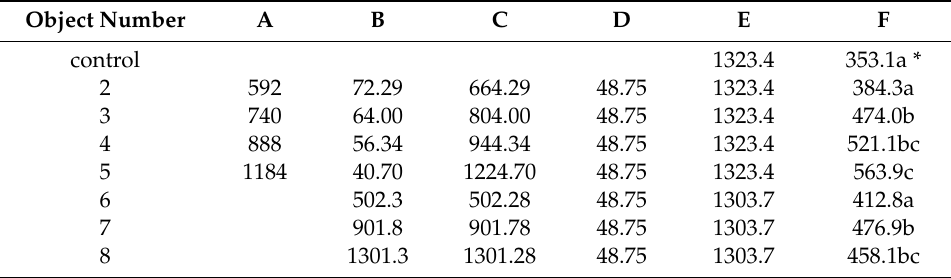
Table 4. CO 2 emissions from fertilizers [CO 2 equivalent · ha − 1 ).